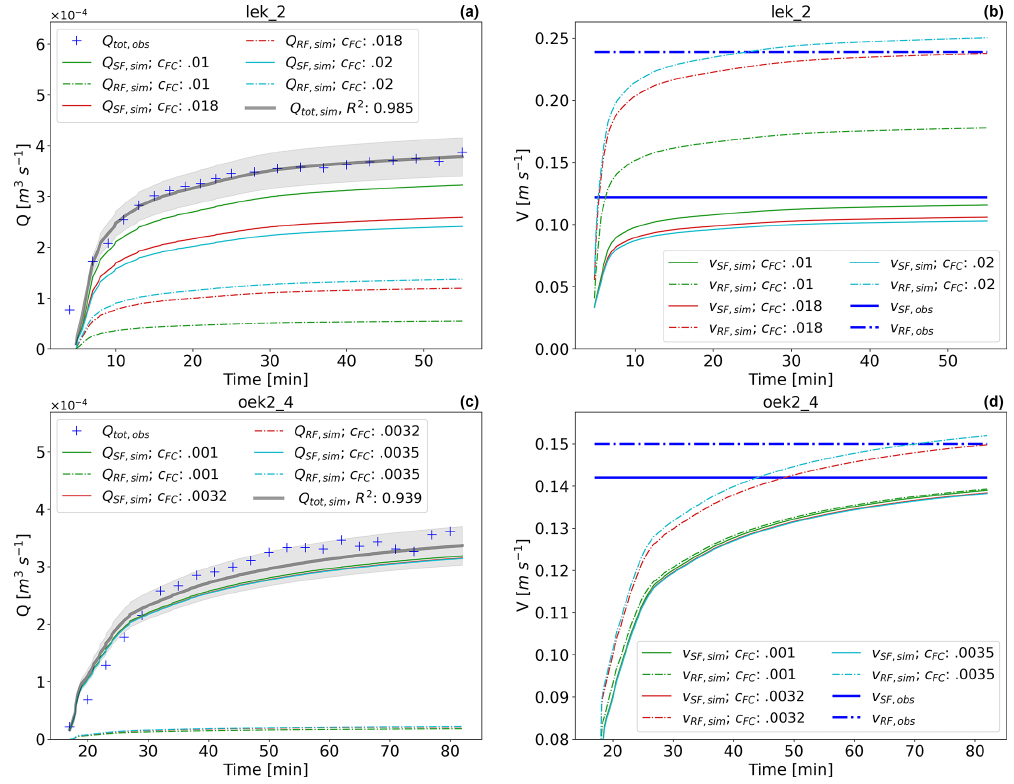
Figure 8. Results of calibrations runs for experiments “lek_2” and “oek2_4”: (a, c) calibrated total discharge Q sim , tot , measured discharge Q tot , obs (inc. grey 10% error band) and computed contributions of sheet flow Q SF , sim and rill flow Q RF , sim ; (b, d) observed rill and sheet flow velocities v RF , obs and v SF , obs and calibration runs for different flow accumulation coefficients C f